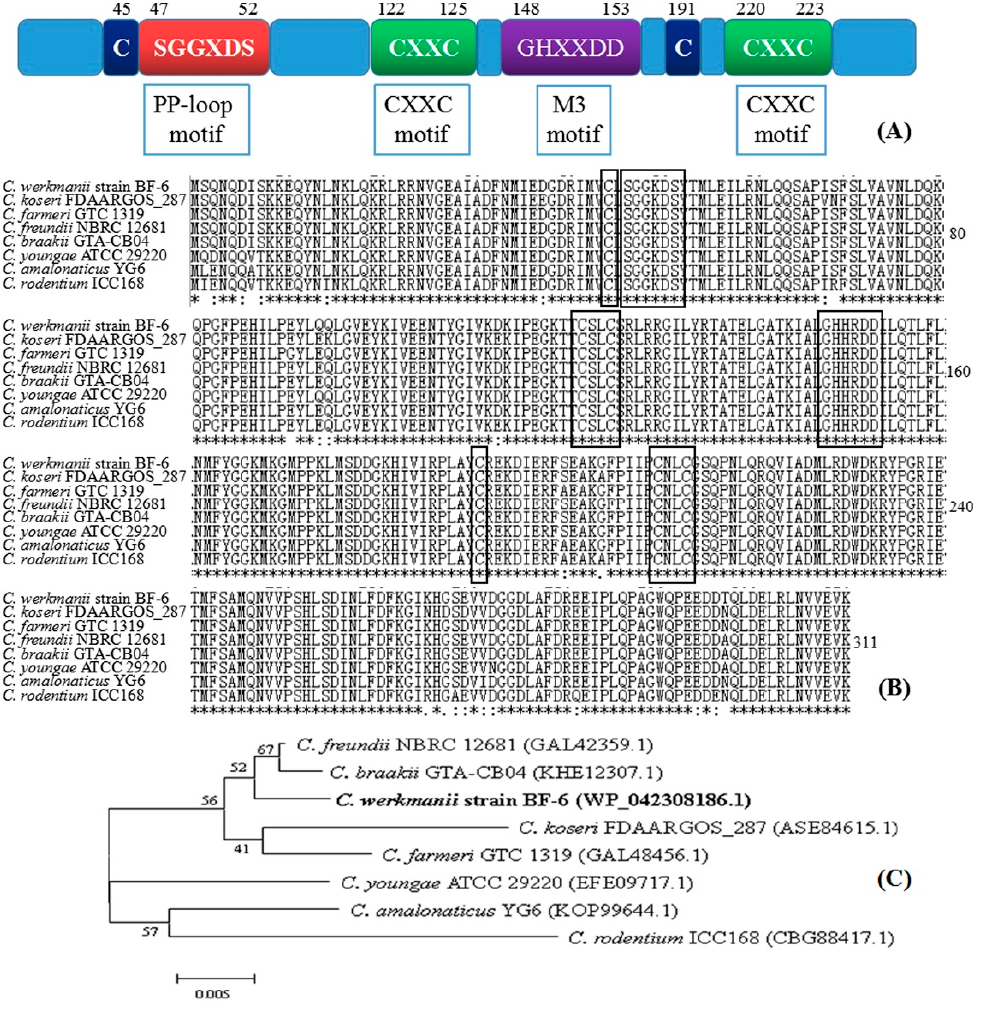
Figure 2. Analysis of the ttcA gene in C. werkmanii BF-6 and encoded protein sequence. Schematic representation of the TtcA protein with its conserved motifs ( A ). Sequence alignment of reported TtcA proteins representatives in the genus Citrobacter ( B ). The alignments were conducted with BioEdit software and the conserved amino acid residues and motifs are framed. Phylogenetic tree of TtcA protein of C. werkmanii BF-6 with the species of the same genus ( C ). This tree was constructed using bootstrapping and Neighbor-Joining methods with MEGA 4.0.